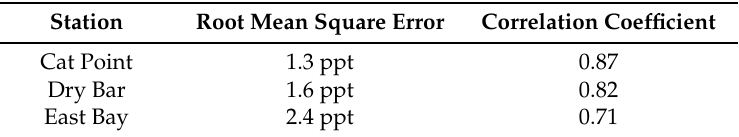
Table 4. Estimation of simulation error.